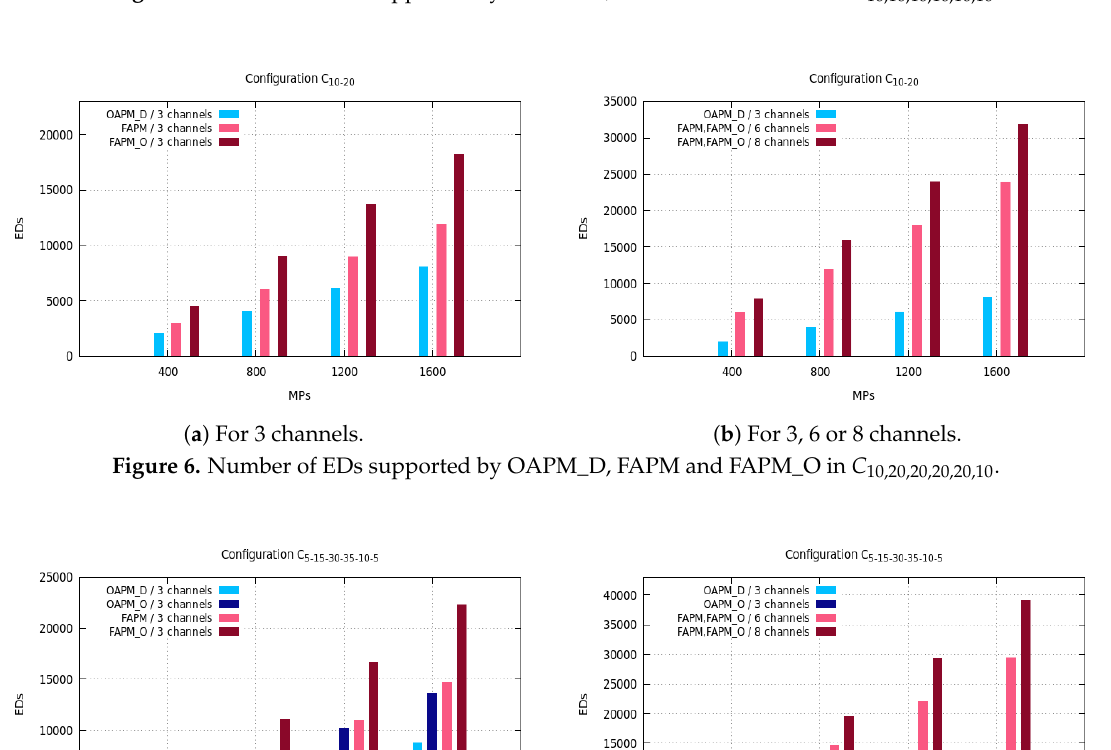
Figure 5. Number of EDs supported by OAPM_D, FAPM and FAPM_O in C 16,16,16,16,16,16 .